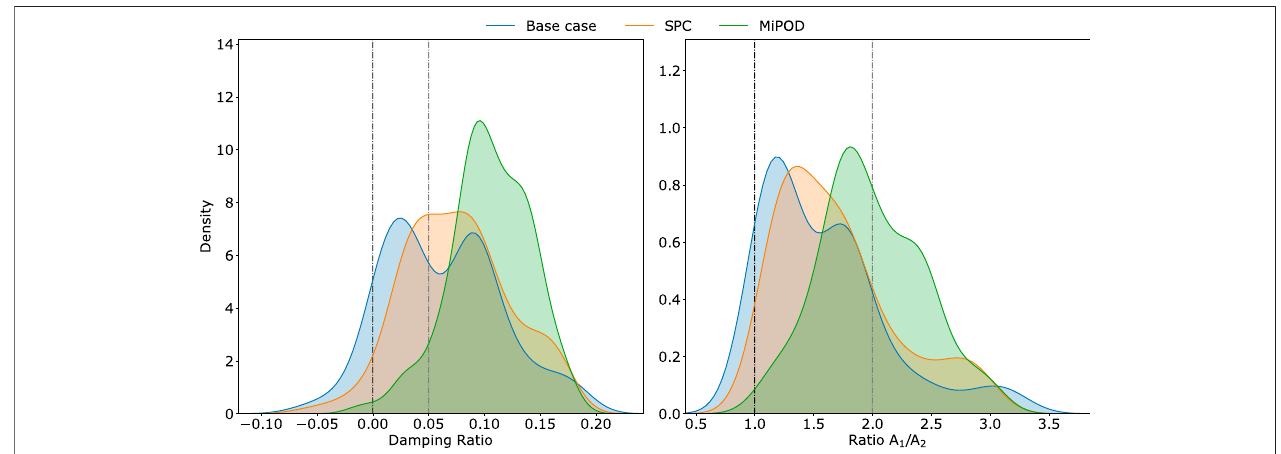
FIGURE 14 | Comparison of the probability density functions for the damping and A 1 / A 2 ratio for the local and inter-area mode combined per study case.